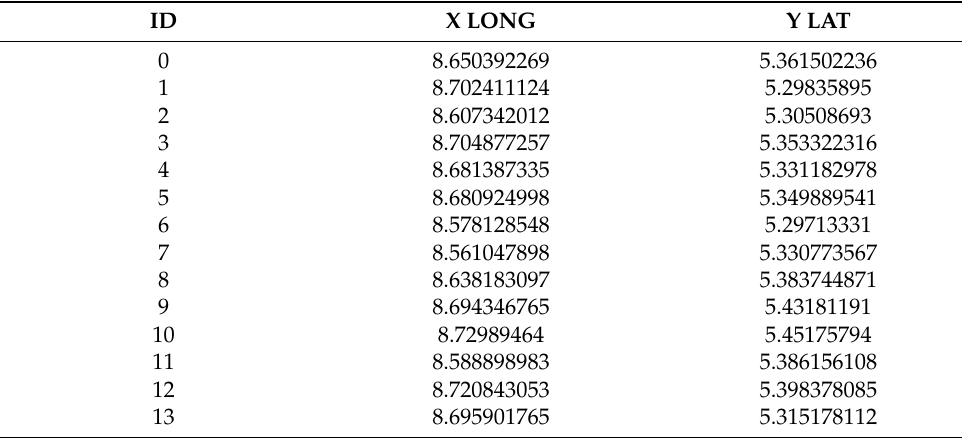
Figure 13. The rosette of fracture directions in the study area. Table 2. Predicted locations for potential occurrence of manganese